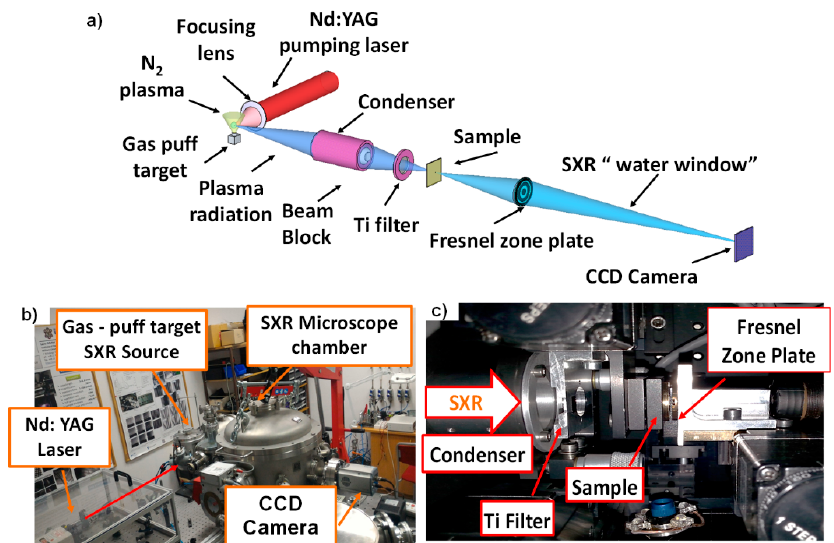
Figure 7. ( a ) Scheme and ( b ) overall view of the “water window” microscope. In ( c ) are shown the internal optical components of the microscope [75,76].